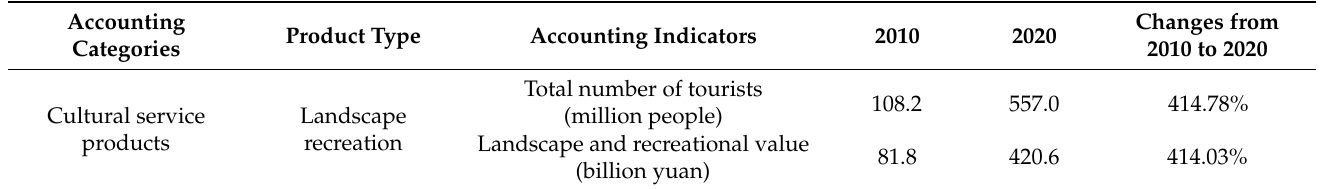
Table 7. Value of cultural service products in Jiangxi Province (2010–2020).